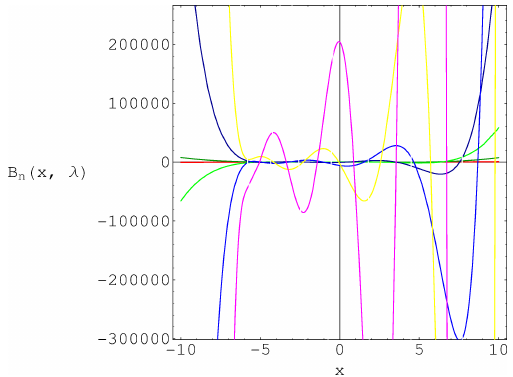
Fig. 2. Zeros of B n